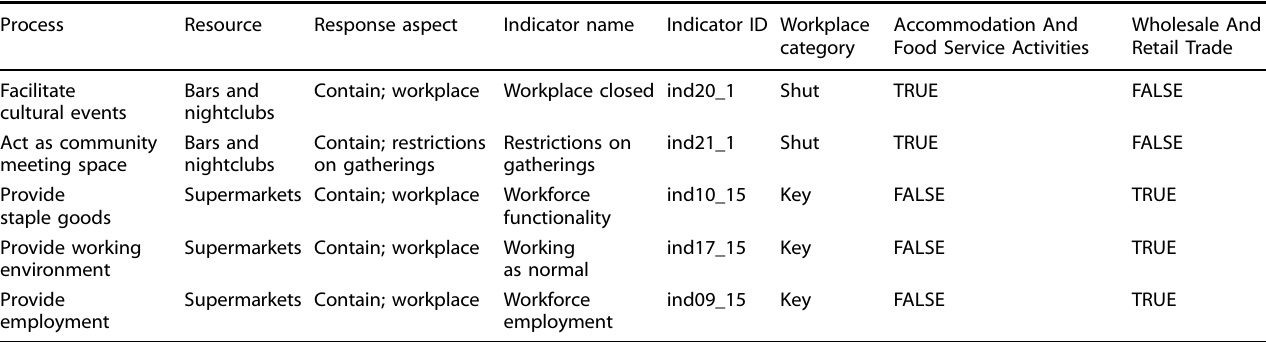
Table 7. Simpli fi ed sample of an edge